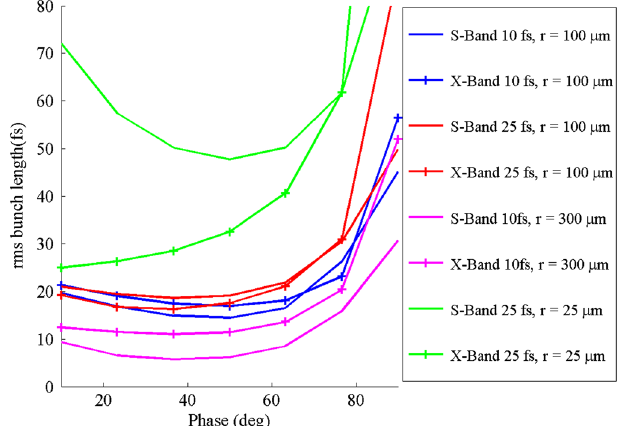
FIG. 7. RMS bunch length versus laser-to-rf phase for different laser pulse durations and spot sizes, but a fixed 30 fC charge (i.e., 2 × 10 5 electrons) calculated at a distance 0.2 m from the